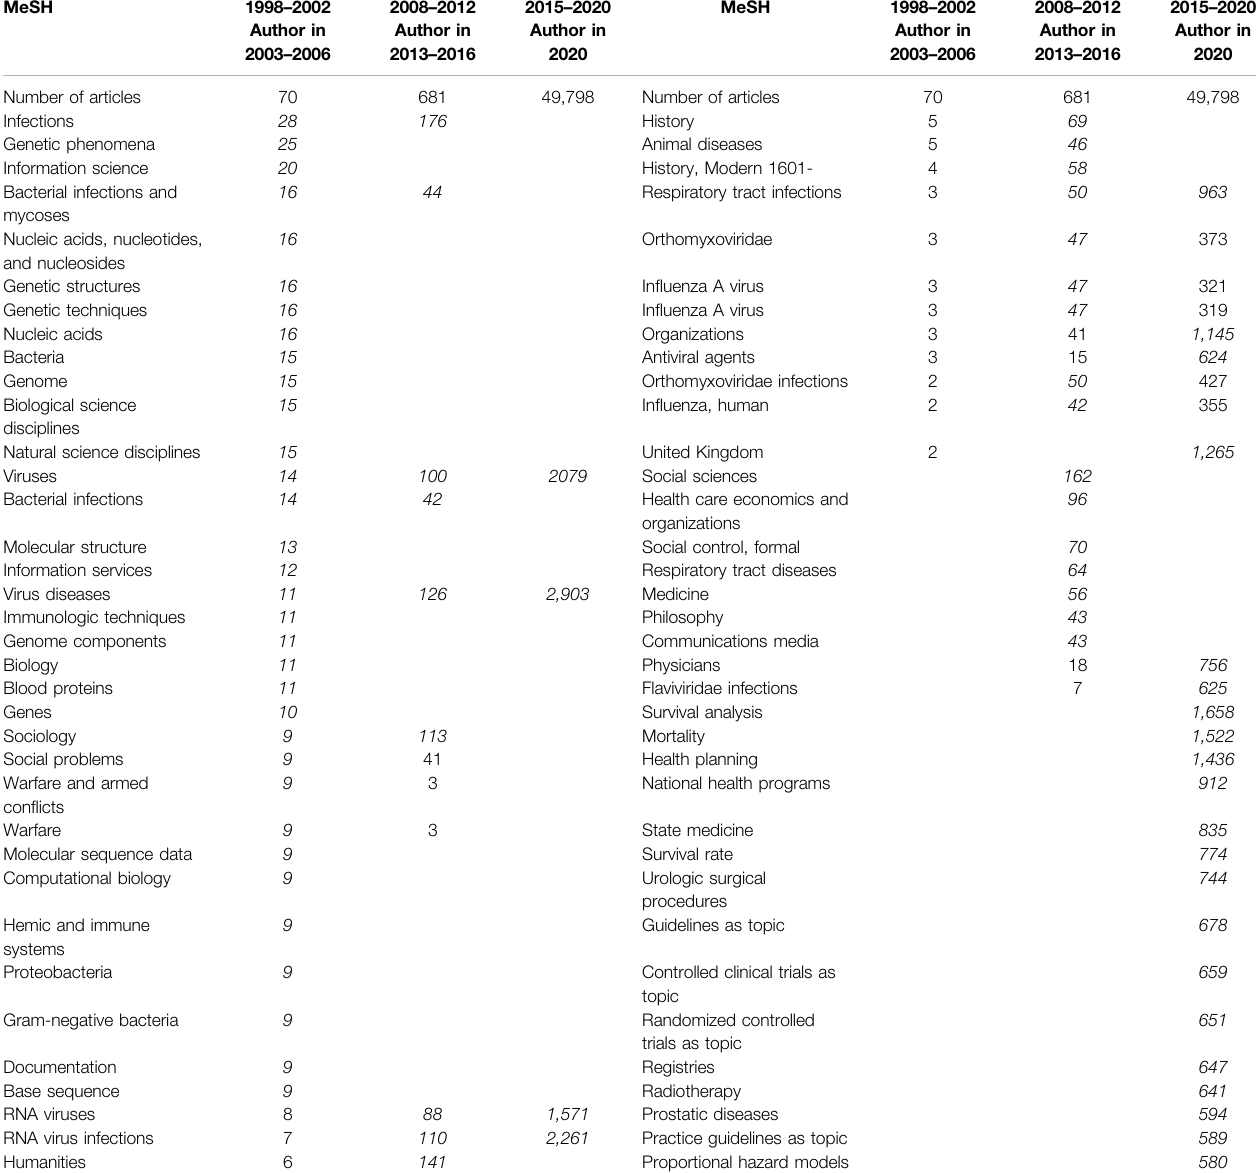
TABLE 2 | Top 25 unique keywords used by newly entered researchers in the past.